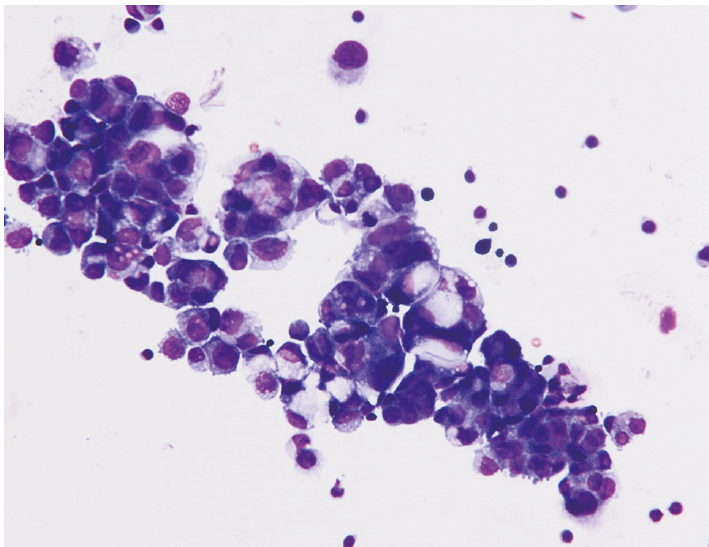
Figure 1: Numerous atypical epithelial clusters were present in the CSF. These atypical cells have eccentric large hyperchromatic nuclei and scant cytoplasm. Some cells show vacuolar changes.